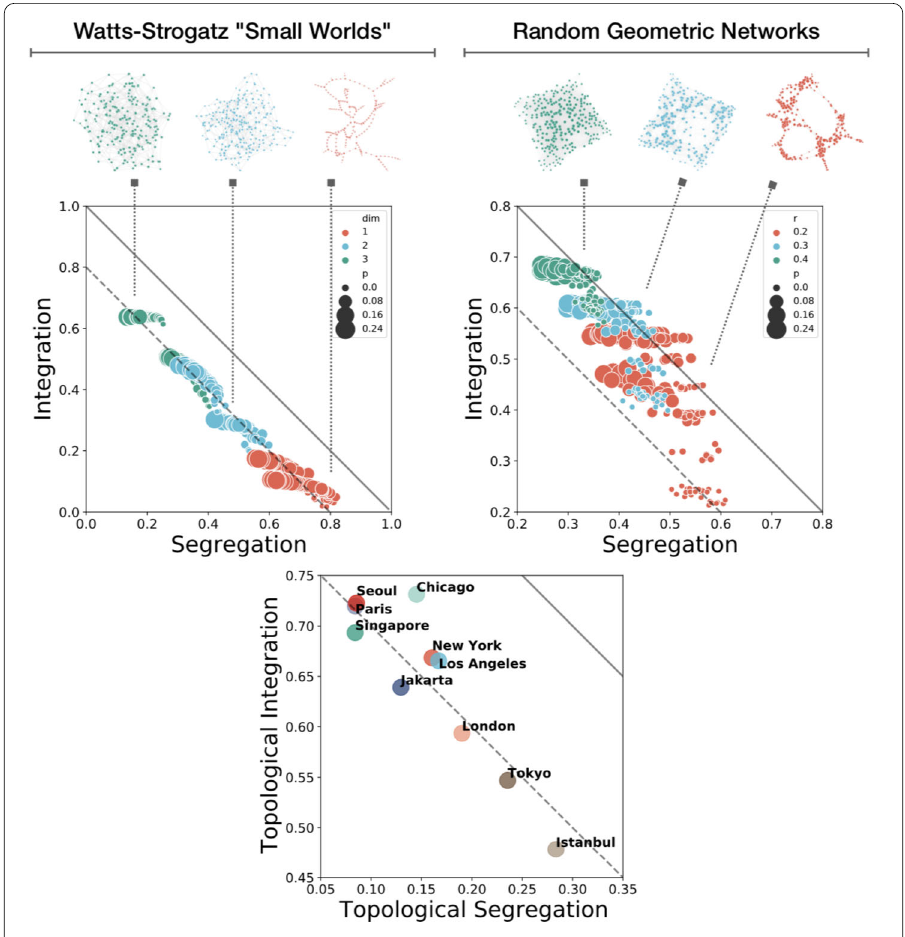
Figure 3 Simulating the functional organisation of synthetic urban models. TopLeft: Small-world networks according to the Watts-Strogatz model (see Methods) with different rewiring probabilities (encoded by size) and dimensions (from 1D to 3D, encoded by color). TopRight: Random Geometric Networks (see Methods) with different characteristic spatial scale (encoded by color) and different rewiring probabilities (encoded by size). Clusters here fall above what observed for WS model. Bottom: The functional organisation of real cities, observed thorough the lens of the topological networks derived from the Foursquare flows (see Methods), follow the same trend as in the that of WS networks. In all panels, the dashed line represents the linear regression relating integration and segregation for the WS model, whereas the solid line is y = 1 – x and it is shown as a